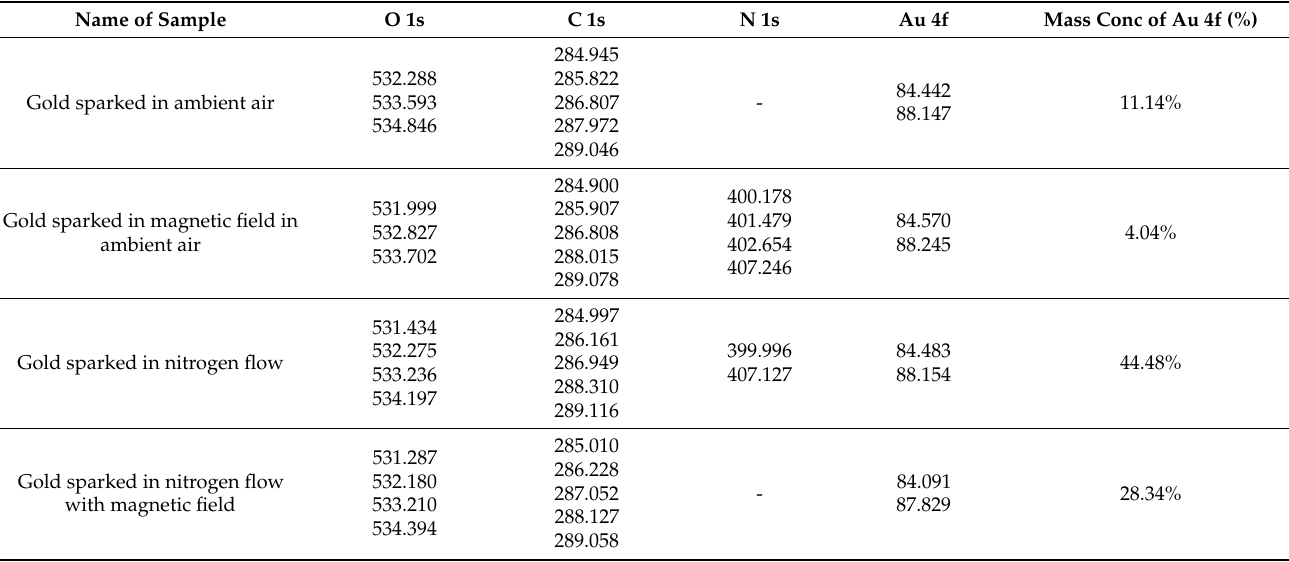
Table 2. XPS oxidation state summary of supplementary